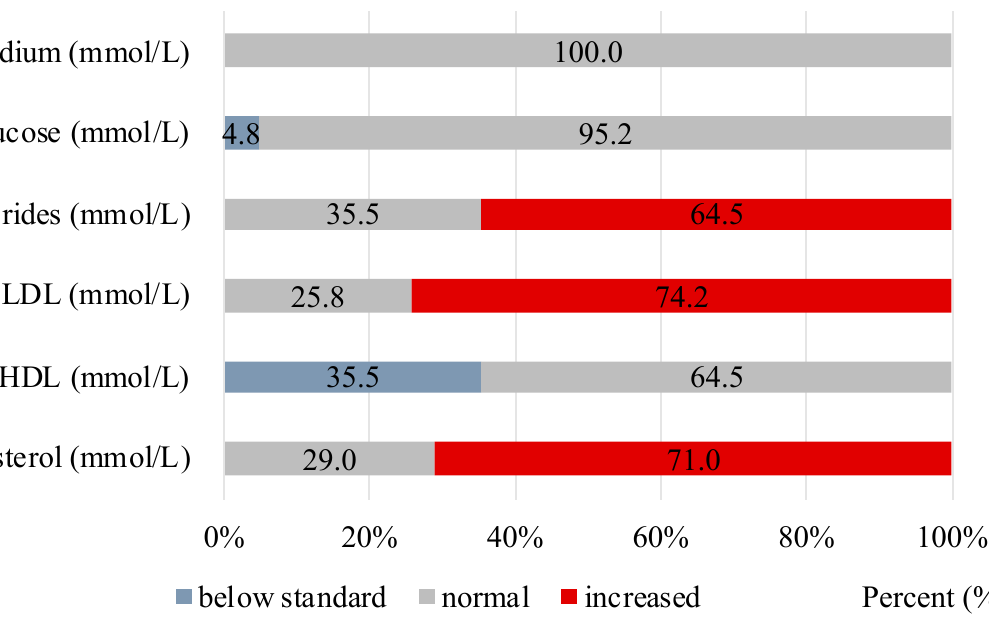
Figure 1. Analysis of results of blood biochemical tests in reference to normal levels of the parameters. Note: HDL, high density lipoprotein; LDL, low density lipoprotein.